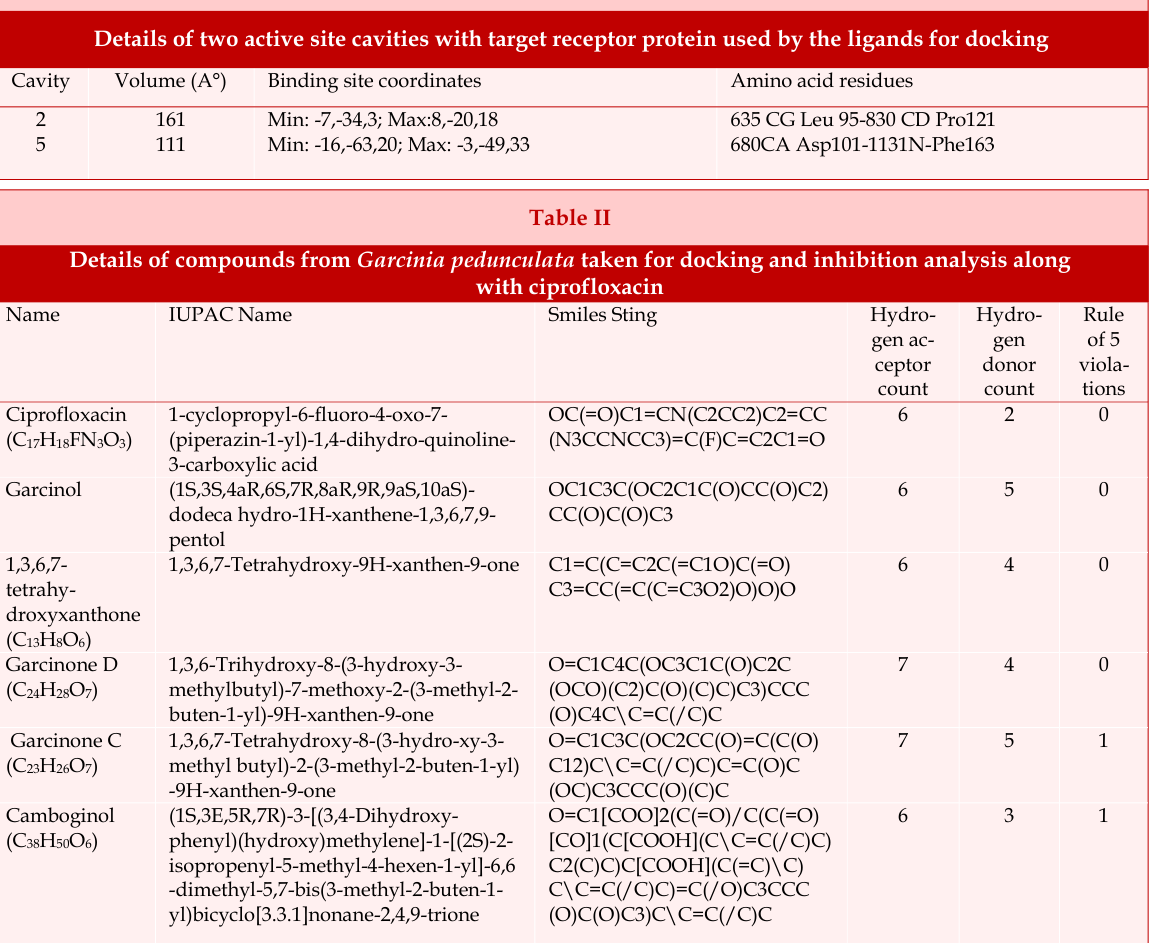
into 2QK7 produced 5 clusters of conformers out of 10 docking runs. The binding energy of -86.8 Kcal/mol at 10 th run had 6 hydrogen bond interactions at residues Lys97, Lys99, Gln107, and Ser119. The docking interact- tions between the ligand and the macromolecule are